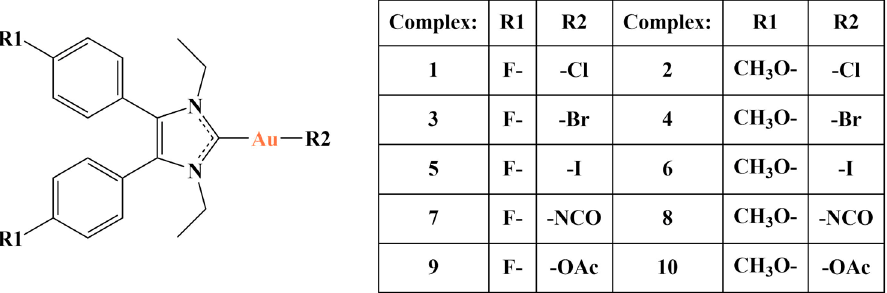
Figure 25. The complexes presented in [102].